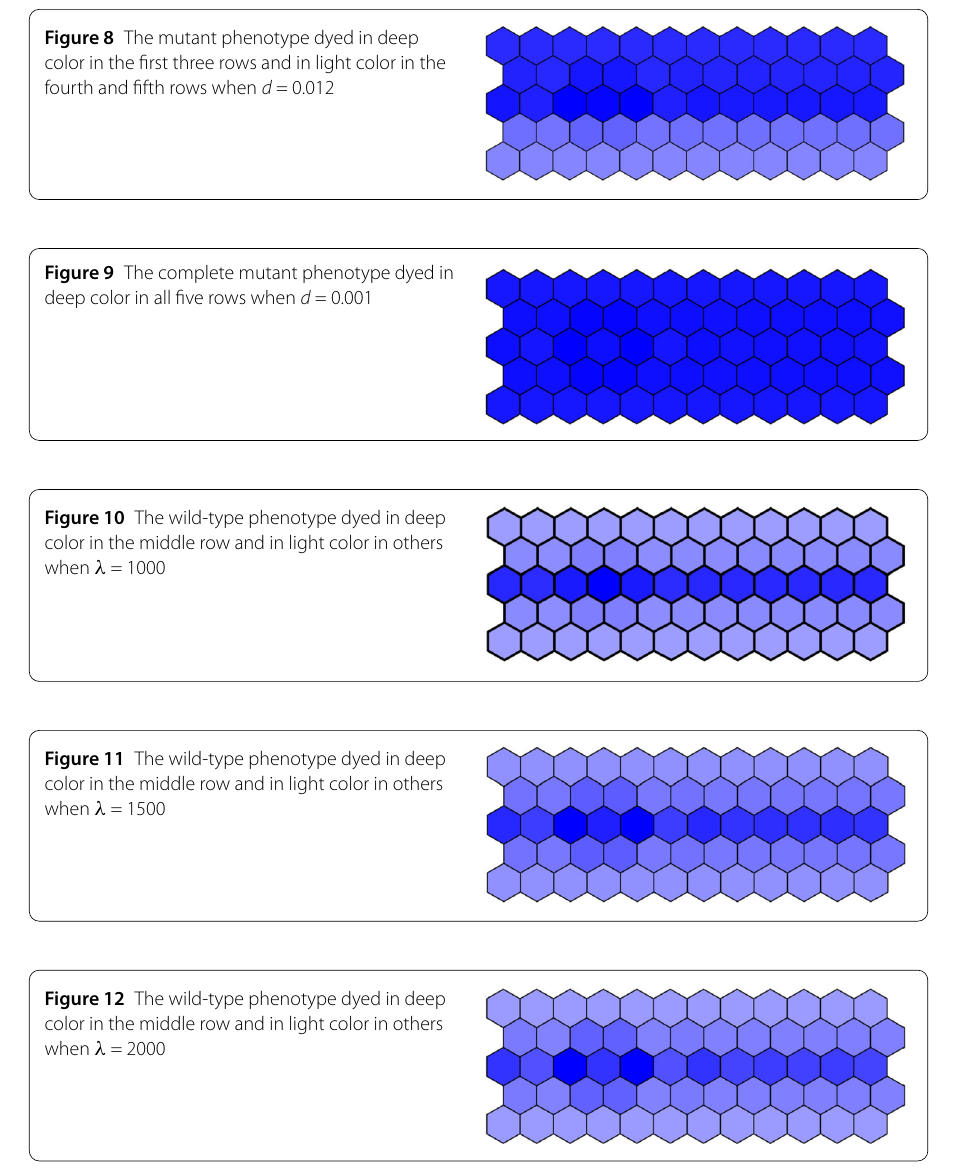
Figure 8 The mutant phenotype dyed in deep color in the first three rows and in light color in the fourth and fifth rows when d = 0.012